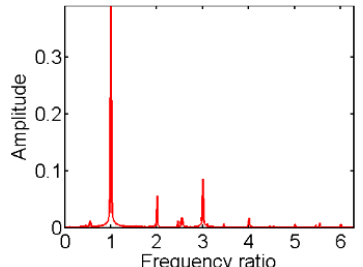
Figure 13. Spectrum diagram of SFD optimized system with misalignment fault.